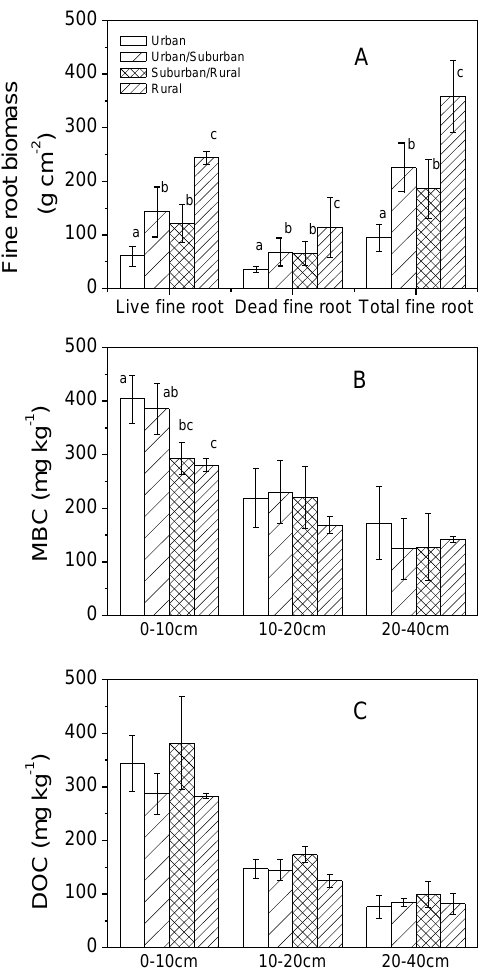
Fig. 4. Comparisons of fine root biomass (A) , MBC (B) , DOC (C) among different urbanization gradient classes. Error bars indicate ± 1S. E. ( N = 3 for urban and rural, N = 4 for urban/suburban Fig 4. Comparisons of fine root biomass (A), MBC (B), DOC (C) among different urbanization 515 and suburban/rural). Different letters indicate significant differences ( P ≤ 0.05) between gradient classes, and no letters indicate no sig- gradient classes. Error bars indicate ± 1 SE (N = 3 for urban and rural, N=4 for urban/suburban and 516 nificant differences ( P >0.05) between different urbanization gra- suburban/rural). Different letters indicates significant difference ( P ≤ 0.05) between gradient classes, 517 dient classes, respectively (SNK test). and no letters indicate no significant differences ( P > 0.05) among different urbanization gradient 518